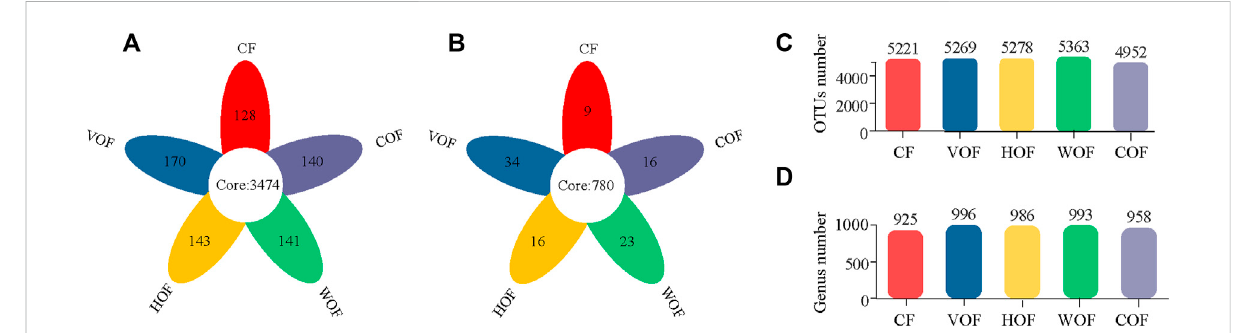
FIGURE 3 Shared, unique, and total numbers of bacterial OTUs (A,C) and genera (B,D) in the rhizosphere soil among the fi ve treatments. CF, VOF, HOF, WOF, and COF represent the treatments of tobacco-special chemical fertilizer, vermicompost-based, humic acid-based, wood biochar-based, and compound functional organic fertilizers,